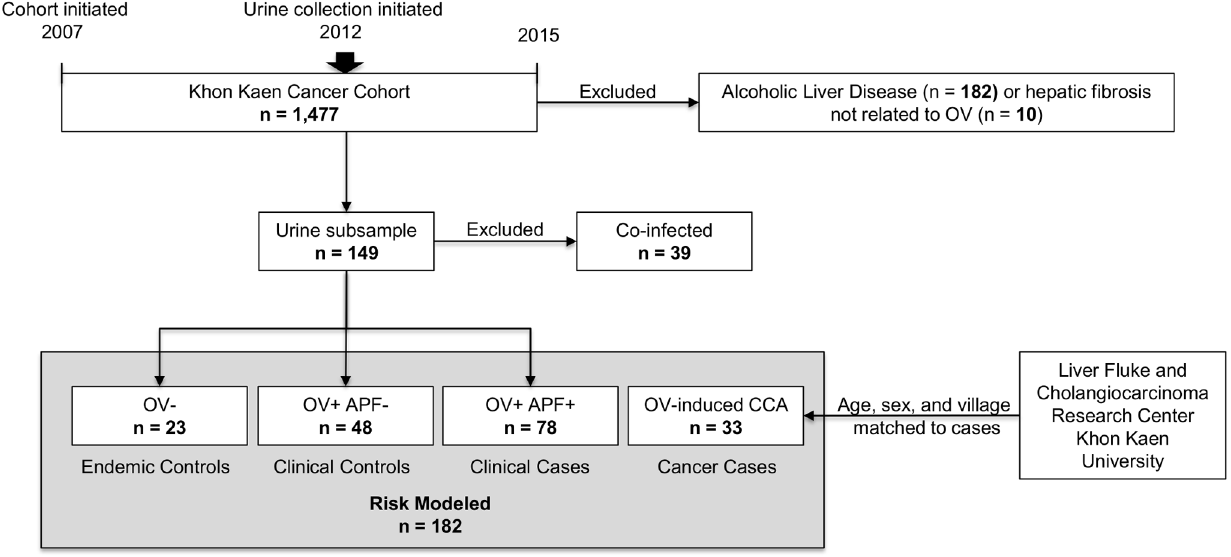
Fig 1. A schematic representation of study participants from Khon Kaen Cancer Cohort (KKCC) and the Liver Fluke and Cholangiocarcinoma Research Center. The KKCC is identified along with approved modifications to the protocol. The exclusion criteria used at various stages are also presented. The stratification of participants into the groups used in the analyses of levels of urine 8-oxodG are